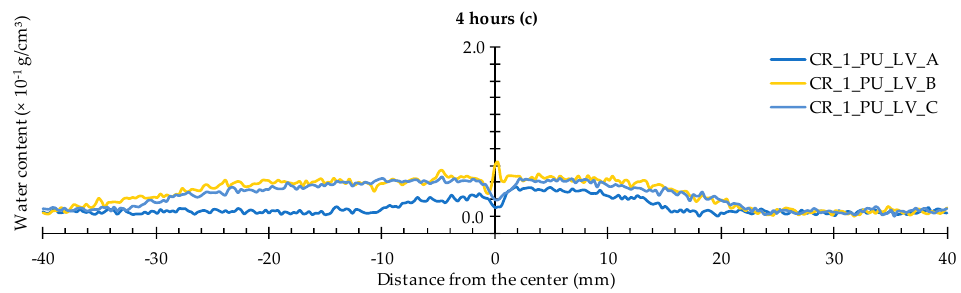
Figure 13. Water profiles of the three standard mortar prisms containing one artificial crack healed with PU_LV: ( a ) after 5 min; ( b ) after 30 min; and ( c ) after 4 h.